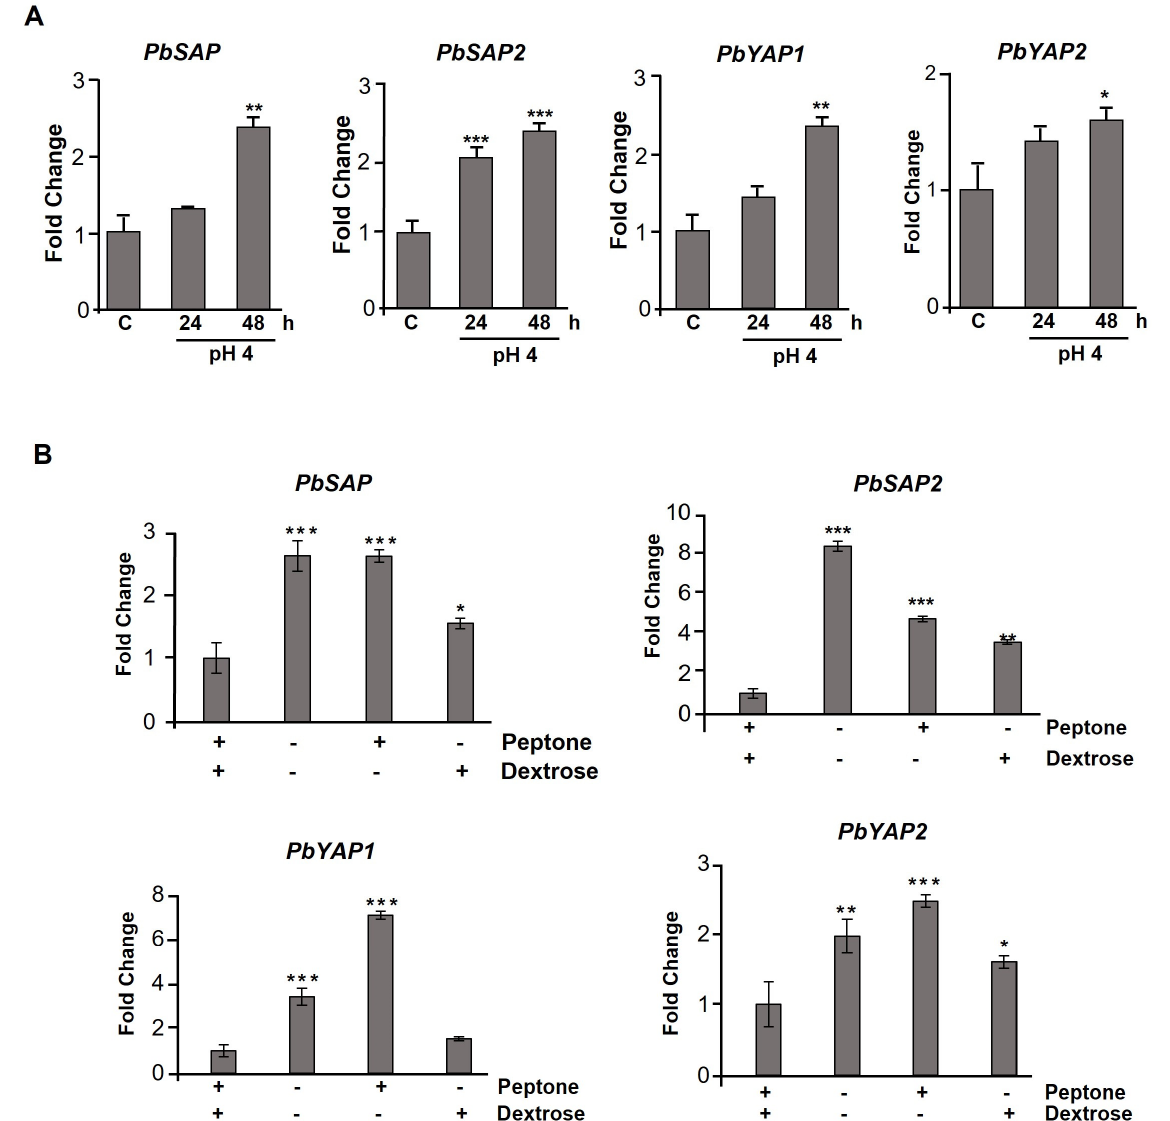
Figure 4. Expression of aspartic protease related genes in P. brasiliensis . ( A ) PbSAP (PADG_00634), PbSAP2 (PADG_03432), PbYAP1 (PADG_12056), and PbYAP2 (PADG_08282) transcript levels were measured in yeast cells cultivated at a pH of 6.5 or 4 for 24 and 48 h. ( B ) P. brasiliensis yeast cells were cultivated in a YNB medium in the presence and absence of peptone (2%) and dextrose (2%), and the expression of aspartic protease genes was analyzed. The change in transcriptional levels was calculated via the 2 −ΔΔ Ct method, with two housekeeping genes ( α -TUB and 18S ). All of the data shown in this fi gure were analyzed using ANOVA (analysis of variance) with Dunnet’s post hoc test. Error bars correspond to the standard deviation of measurements performed in triplicate, and asterisks indicate statistically signi fi cant di ff erences in expression (* p ≤ 0.05, ** p ≤ 0.01 and *** p ≤ 0.001). The results shown are representative of three independent experiments.